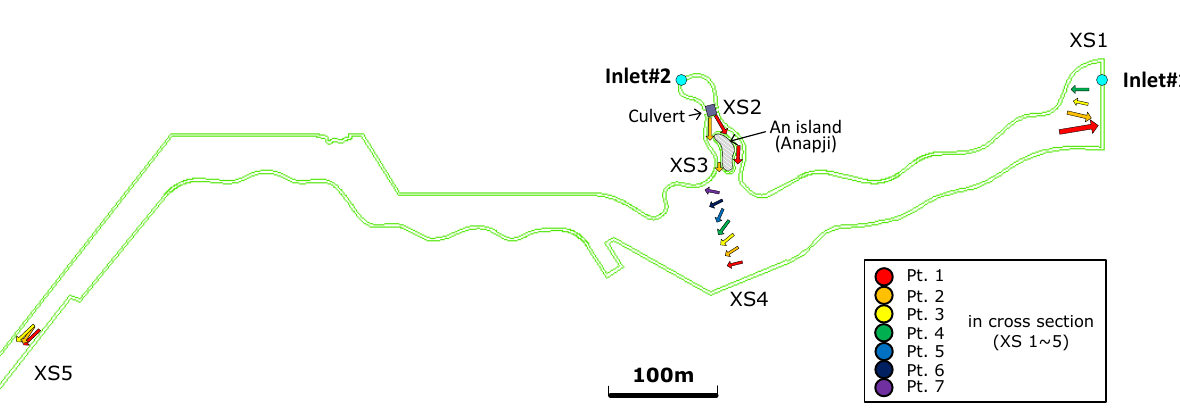
Figure 6. Measured velocity of each cross section